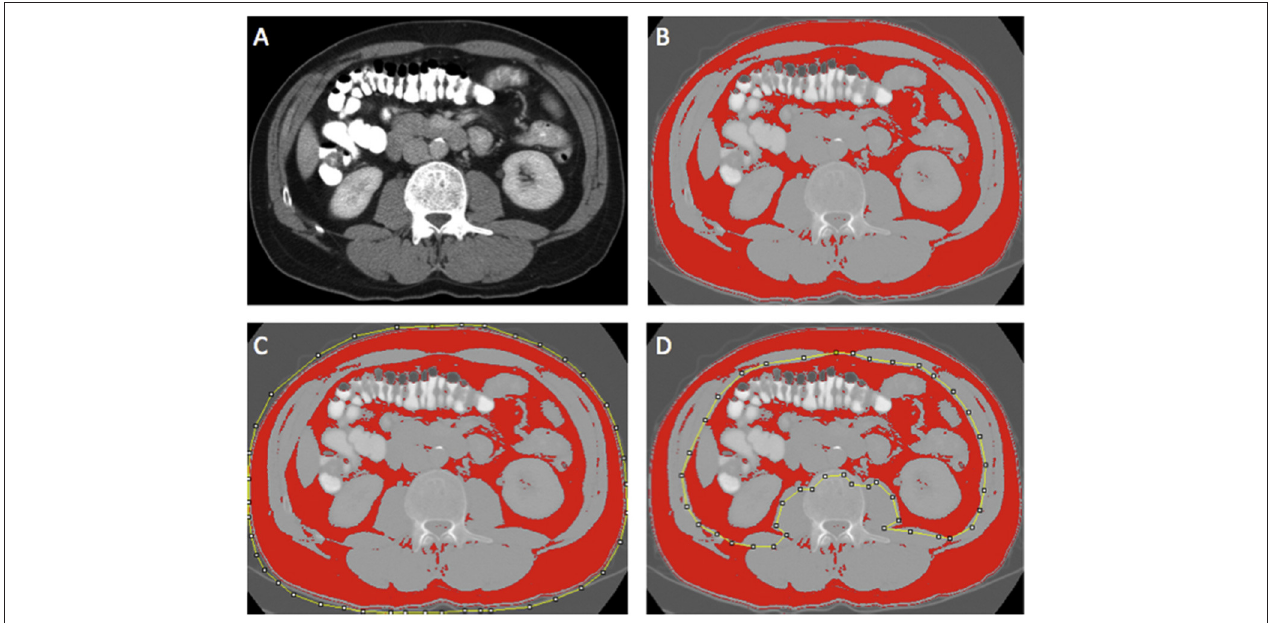
FIGURE 2 | Example of selection of CT body composition—fat areas using ImageJ software; (A) mid-L3 vertebra axial slice from preoperative portal venous phase CT, (B) threshold selection of adipose tissue using automatic selection of pixels of radiodensity ranging − 190 to − 30 Hounsfield units (HU); (C) region of interest (ROI) selection for total fat area (TFA, cm 2 ); and (D) ROI selection for visceral fat area (VFA, cm 2 ). Adapted from McSorley et al. (